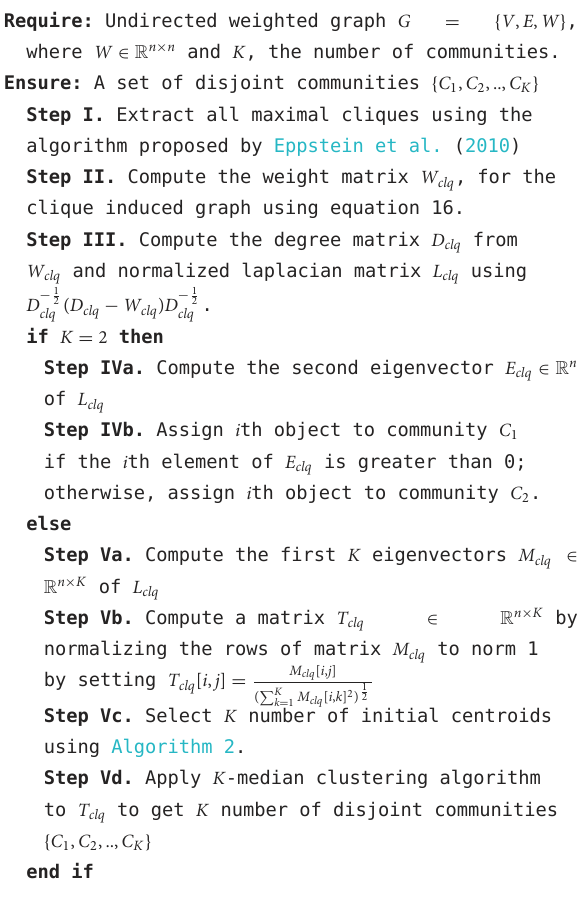
Algorithm 1. Proposed weighted graph partitioning algorithm.